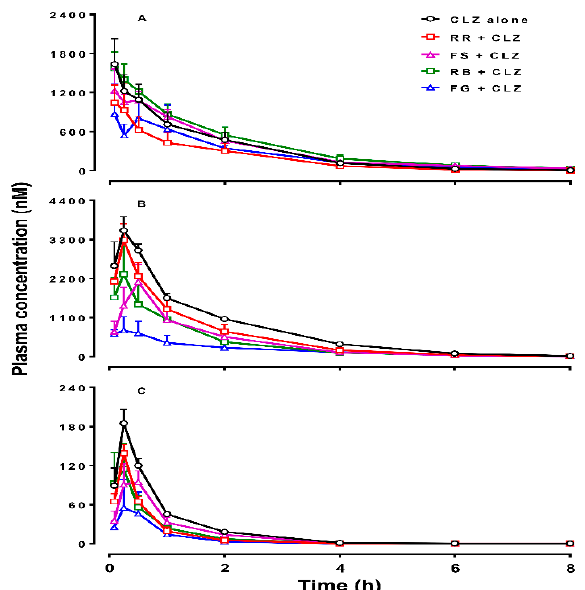
Figure 1. Plasma concentrations of clozapine (CLZ, A ), norclozapine (norCLZ, B), and clozapine N- oxide (CLZ N -oxide, C ) over time in rats treated with an intraperitoneal dose of 10 mg/kg of CLZ alone ( n = 5), or pretreated orally with Radix Rehmanniae (RR; n = 4), Fructus Schisandrae (FS; n = 6), Radix Bupleuri (RB; n = 6), and Fructus Gardeniae (FG; n = 4), respectively. The data are presented as mean ± SEM.